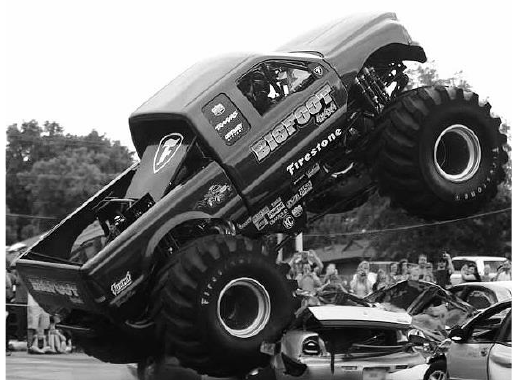
Figure 1. The bigfoot monster truck.